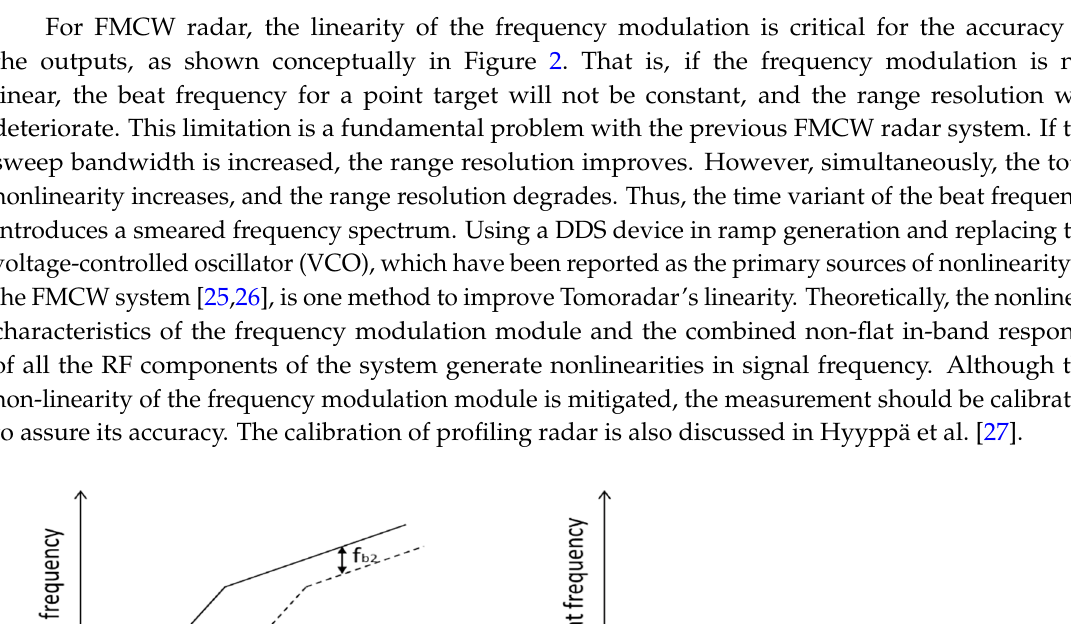
Figure 3 . Range calibration.